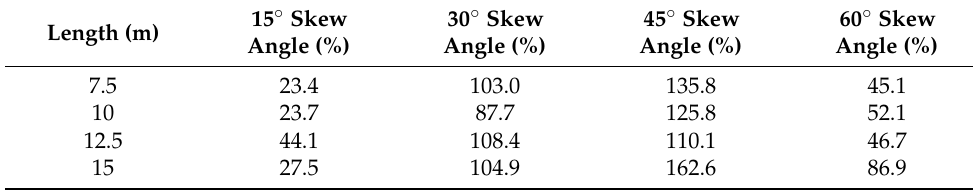
Table 4. Increase in LFEA M t,max demand versus AASHTO LRFD capacity.